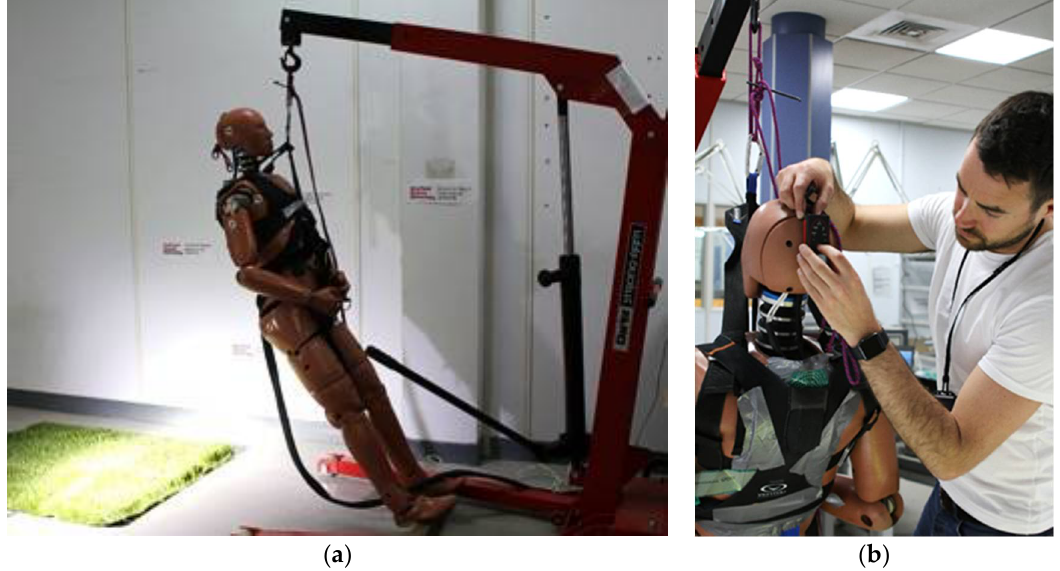
Figure 2. ( a ) ATD in full-body harness supported by hoist with quick release mechanism; ( b ) ATD wearing mock-EPTS device in standard padded vest with pressure sensor between the vest and ATD.